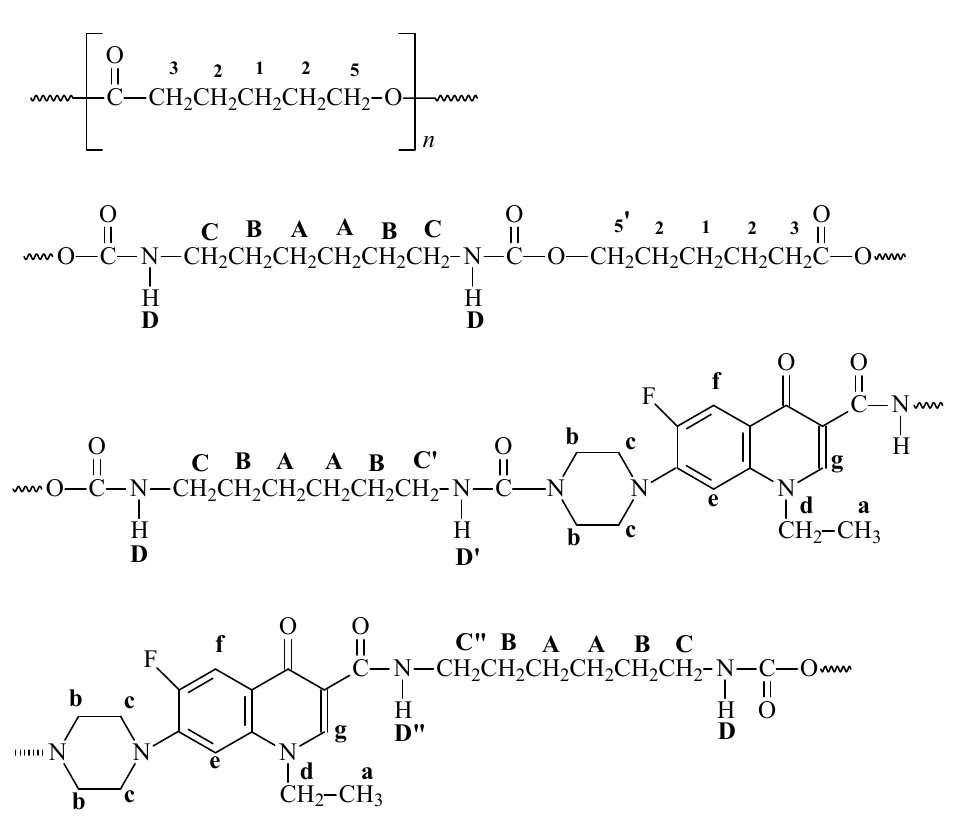
Figure 3. The 1 H-NMR spectrum of the conjugate: NOR-PUR (PCL-HDI) (in DMSO-d (Table 2, Run no.